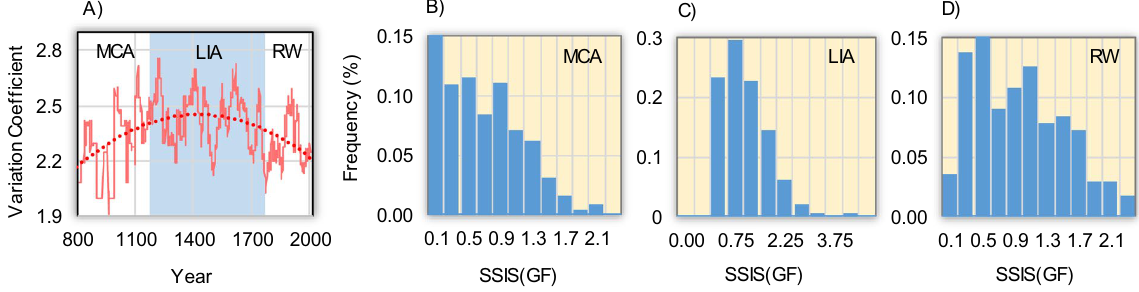
Figure 4. Multidecadal variability of variation coefficients of the SSI for all the regions with ( A ) moving- window of 31-years with an over-imposed polynomial dotted curve, ( B ) relative percentage frequency of SSIS(GF) distribution pattern over 800–1250 (MCA: Medieval Climate Anomaly), ( C ) 1250–1849 (LIA: Little Ice Age), and ( D ) 1850–2017 (RW: Recent